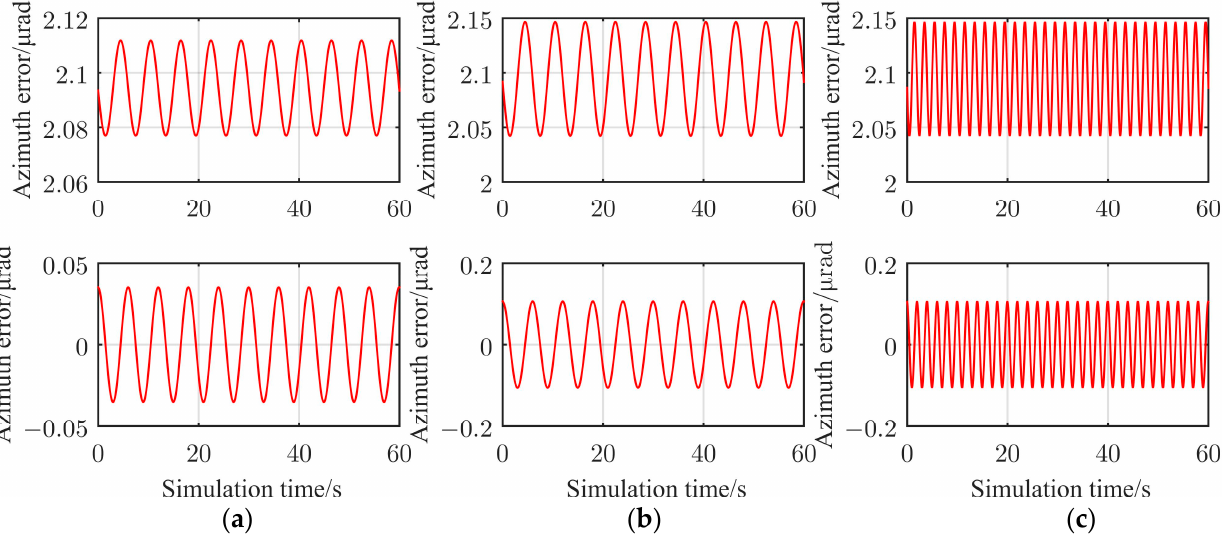
Figure 11. The LOS attitude curves under the condition of conical motion in an ideal state in the